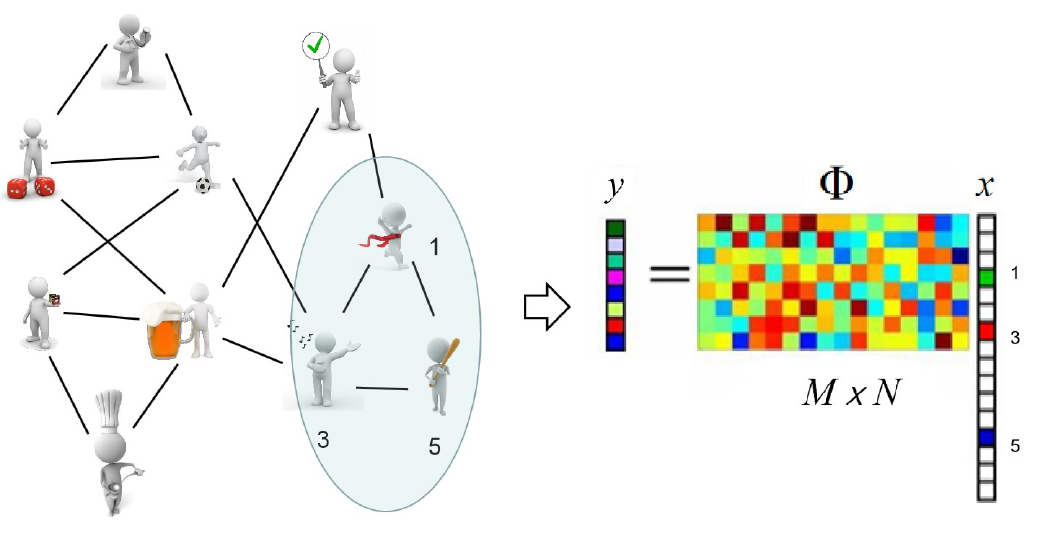
Figure 5. Identification of complex network model based on compressed sensing and QR decomposition